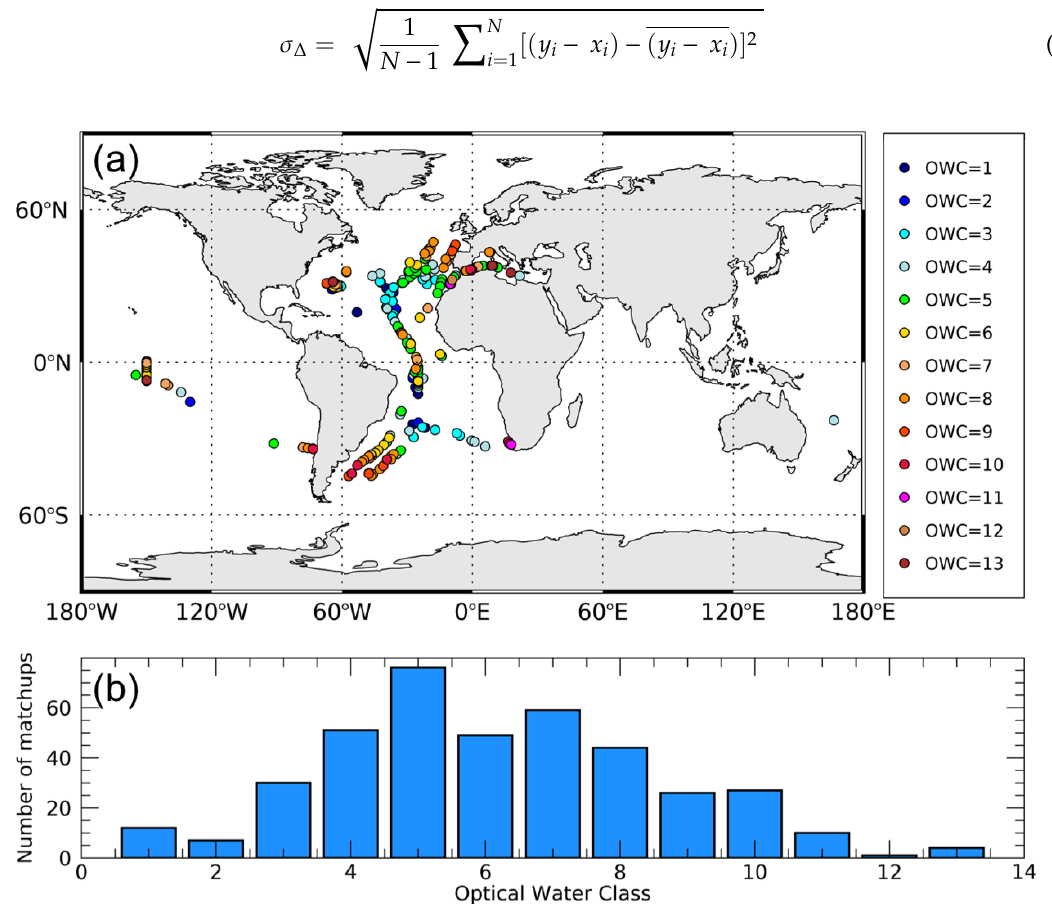
Figure 1. Geographical distribution of the matchup dataset (N = 396) used for the analysis. Each datapoint is also associated with the specific Optical Water Class (OWC) ( a ). Number of matchups per OWC ( b ).